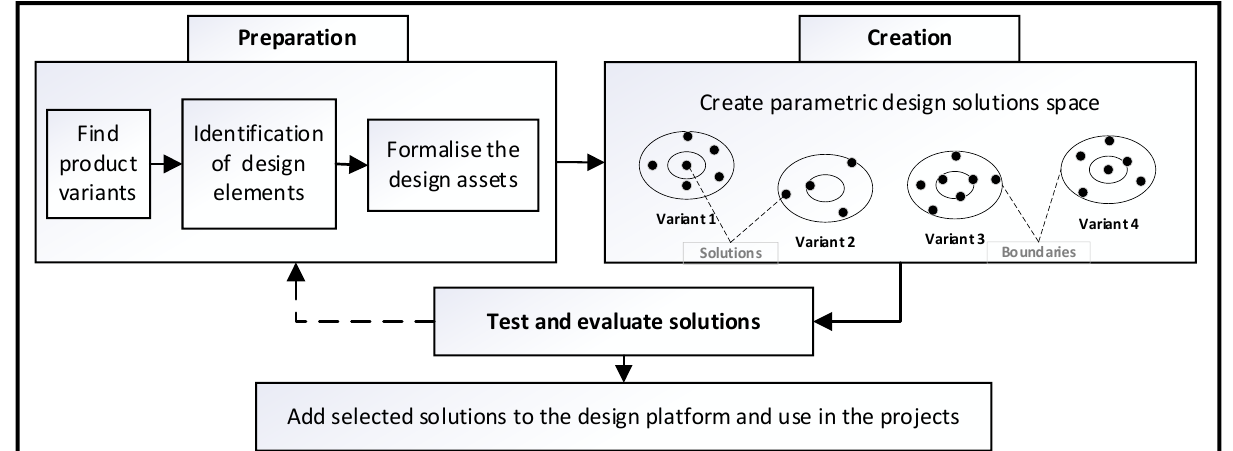
Figure 7. Parametric design platform approach.